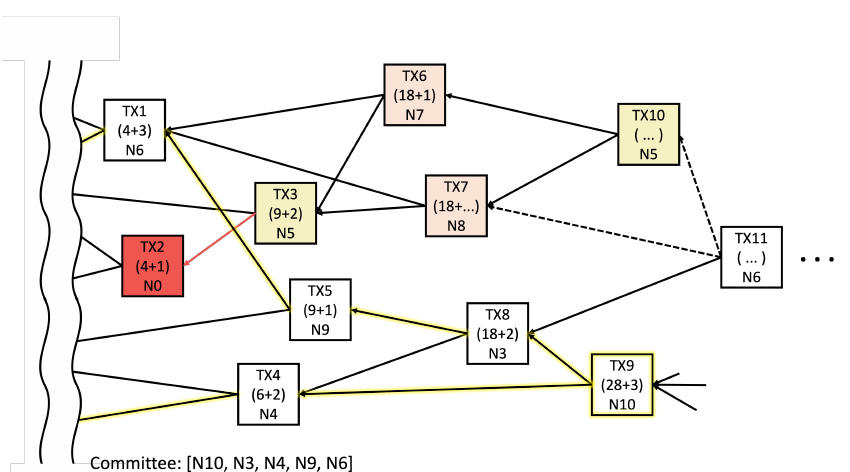
Figure 2. Example of tip selection: the white transaction, a normal model; the red transaction, a poisoned model; the other color transaction, a model contaminated by aggregating a poisoned transaction.